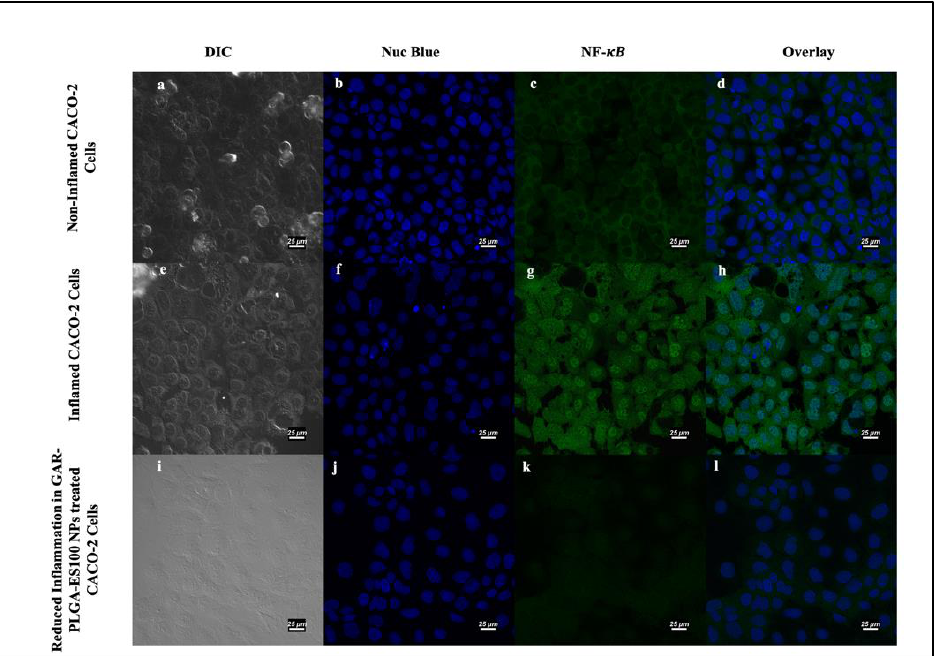
Figure 8. Induction and inhibition of inflammation in CACO-2 cells by confocal microscopy: non- inflamed CACO2 cells ( a – d ); inflamed CACO-2 cells treated with proinflammatory cocktail com- prising of IL-6, TNF-α, and LPS at 0.2, 0.3, and 20 μg/mL, respectively, for 3 h used to observe the expression of NF-κB ( e – h ). Reduction in the expression of NF-κB occured in CACO-2 cells after treatment with GAR-PLGA-ES100 NPs (250 μg/mL) for 48 h ( i – l ) (at scale 25μm).